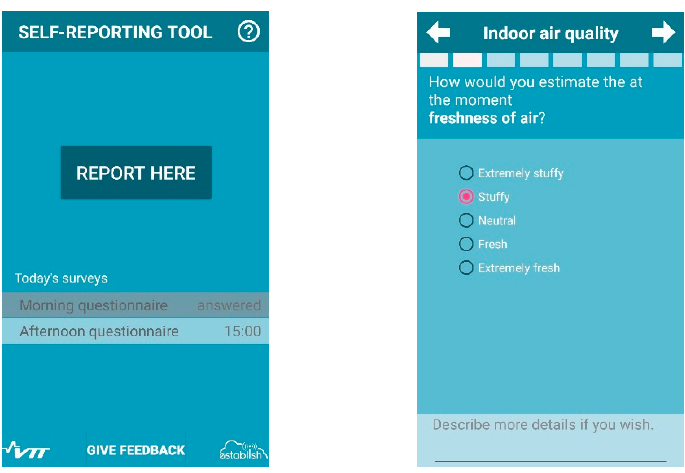
Figure 1. Screenshots from the self-reporting